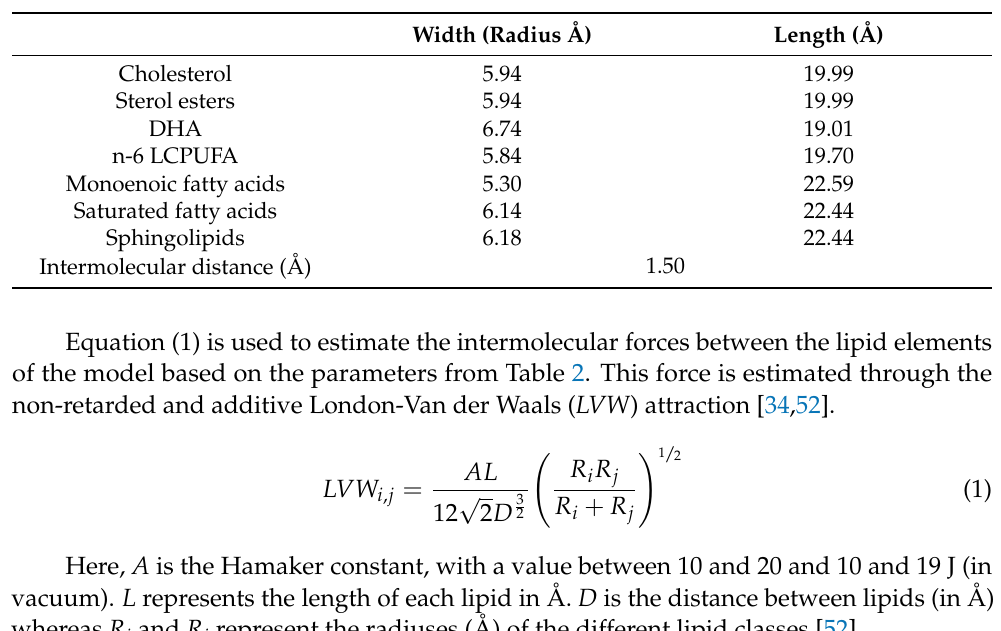
Table 2. Model parameters estimated from mice frontal cortex membranes [24] to represent lipid classes as cylinders in the agent-based